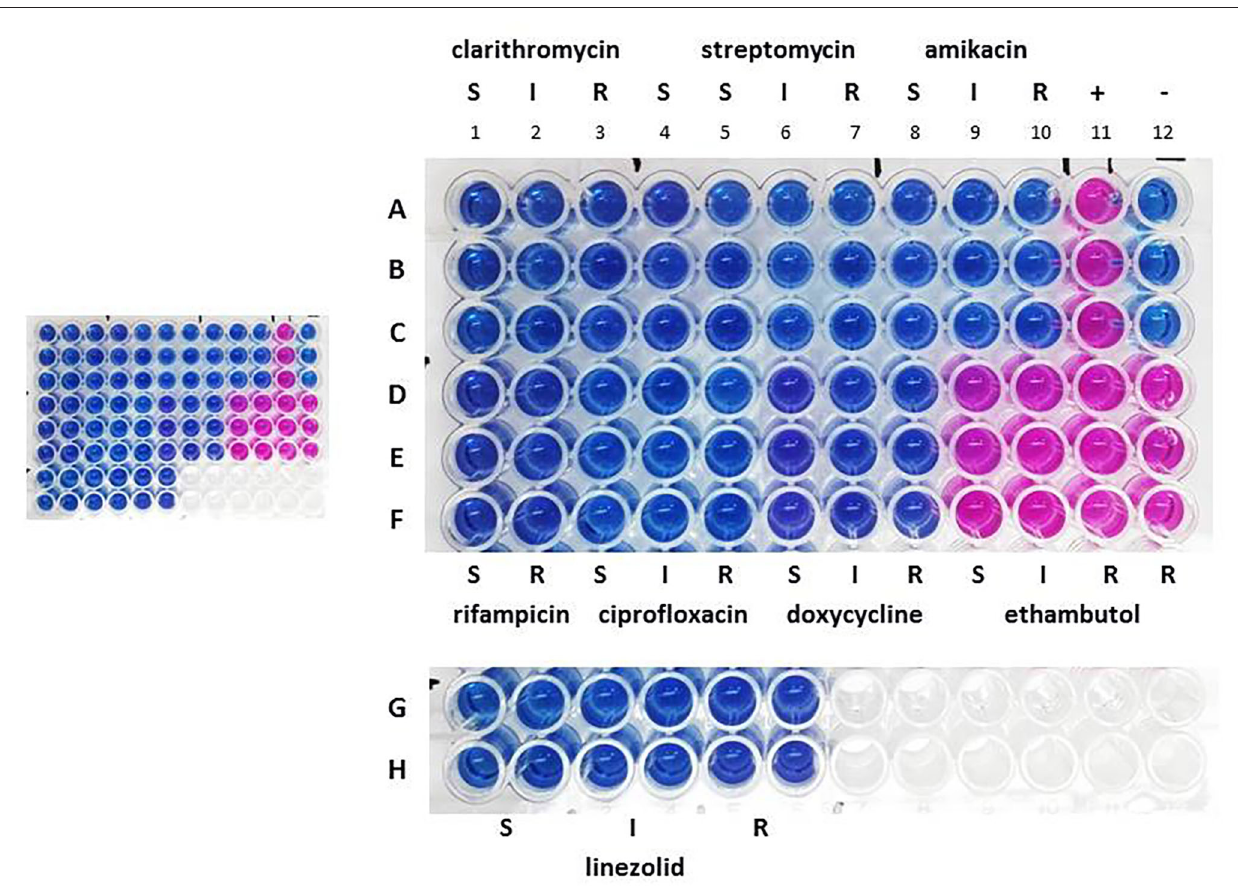
FIGURE 1 | Drug susceptibility profile the primary broth culture. A–F: sample triplicates. G, H: sample quadruplicates. S, susceptible; I, intermediate; R, resistant. Lines A–C, columns 1–3: 16.0 (S), 32.0 (I), and 64.0 (R) µ g ml − 1 for clarithromycin; columns 4–7: 8.0 (S), 16.0 (S), 32.0 (I), and 64.0 (R) µ g ml − 1 for streptomycin; columns 8–10: 16.0 (S), 32.0 (I), and 64.0 (R) µ g ml − 1 for amikacin; column 11: positive control containing no drug ( + ); column 12: negative control containing uninoculated medium (–). Lines D–F, columns 1, 2: 1.0 (S) and 2.0 (R) µ g ml − 1 for rifampicin; columns 3–5: 1.0 (S), 2.0 (I), and 4.0 (R) µ g ml − 1 for ciprofloxacin; columns 6–8: 1.0 (S), 8.0 (I), 16.0 (R) µ g ml − 1 for doxycycline; columns 9–12: 2.0 (S), 4.0 (I), 8.0 (R), 16.0 (R) µ g ml − 1 for ethambutol. Lines G, H, columns 1, 2, 3, 4, 5, 6: 8.0 (S), 16.0 (I), 32.0 (R) µ g ml − 1 for